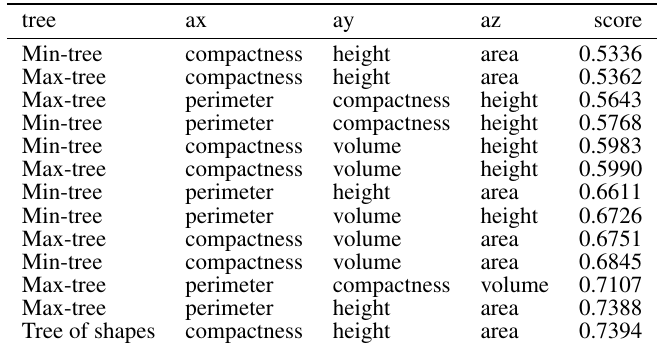
Table 4. 3D spectra intersection of gold panning and background with selected attributes (lower is